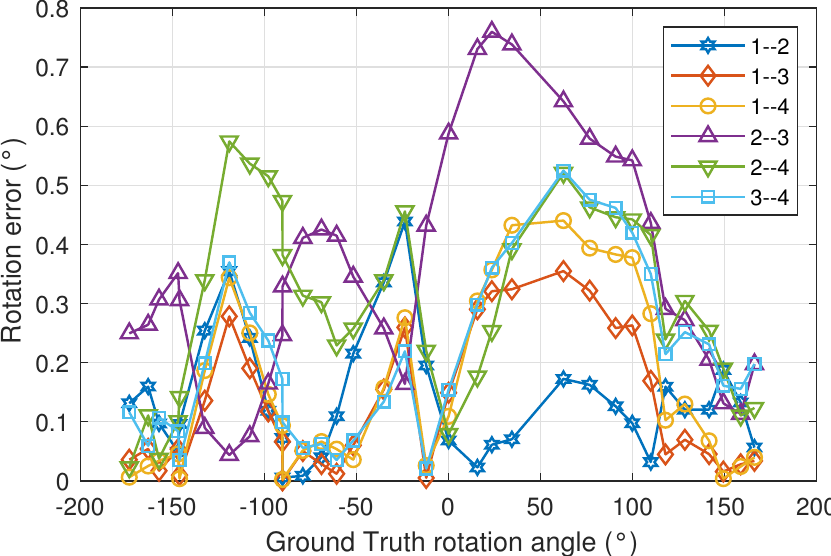
Figure 10. Rotation error as a function of true values of the rotation angles for all combinations of emitter pairs.